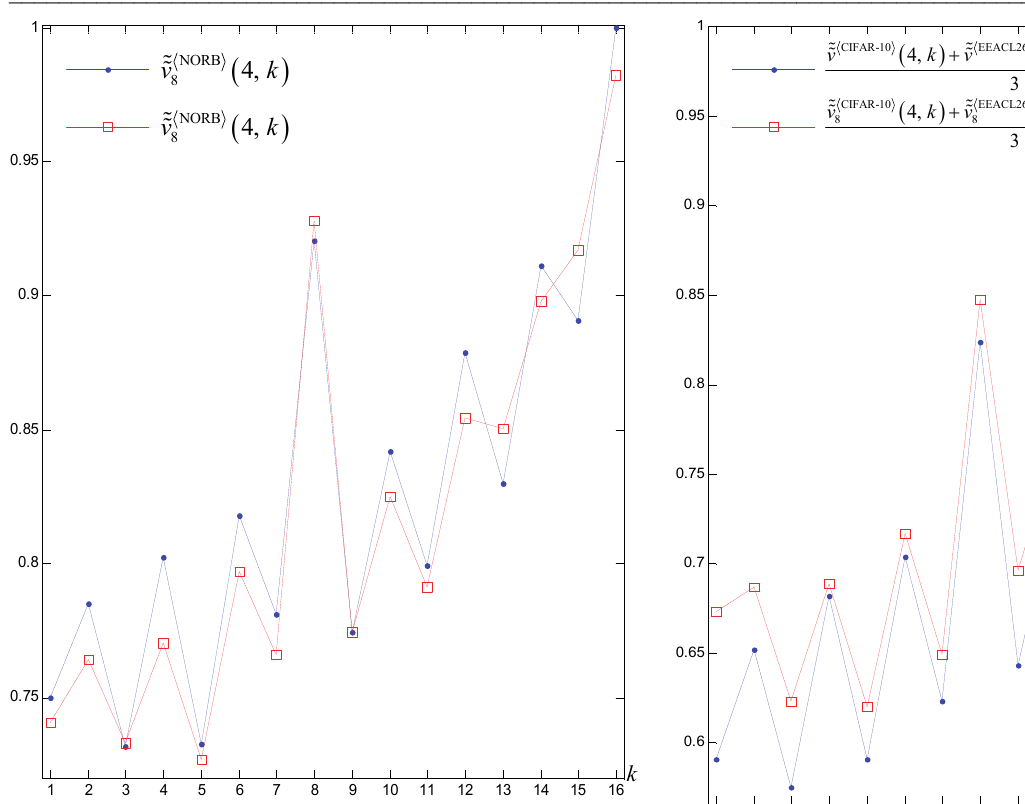
Fig. 8. Performance of CNNs with 4 ConvLs on NORB. Minima coincide corresponding, strangely enough, to